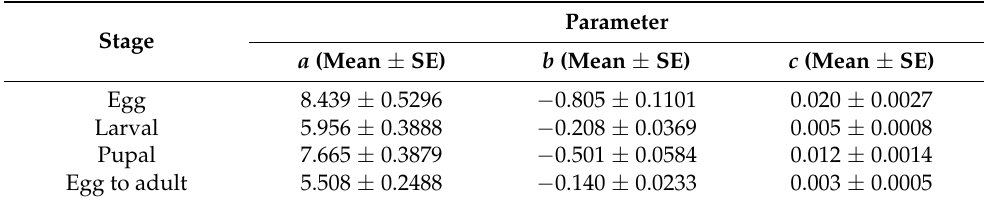
Figure 2. Temperature-dependent survival models (solid lines) for Feltiella acarisuga . Open circle data points are not experimental data but imaginal points, the lower development thresholds. Table 5. Estimated parameter values of the temperature-dependent survival model for Feltiella acarisuga